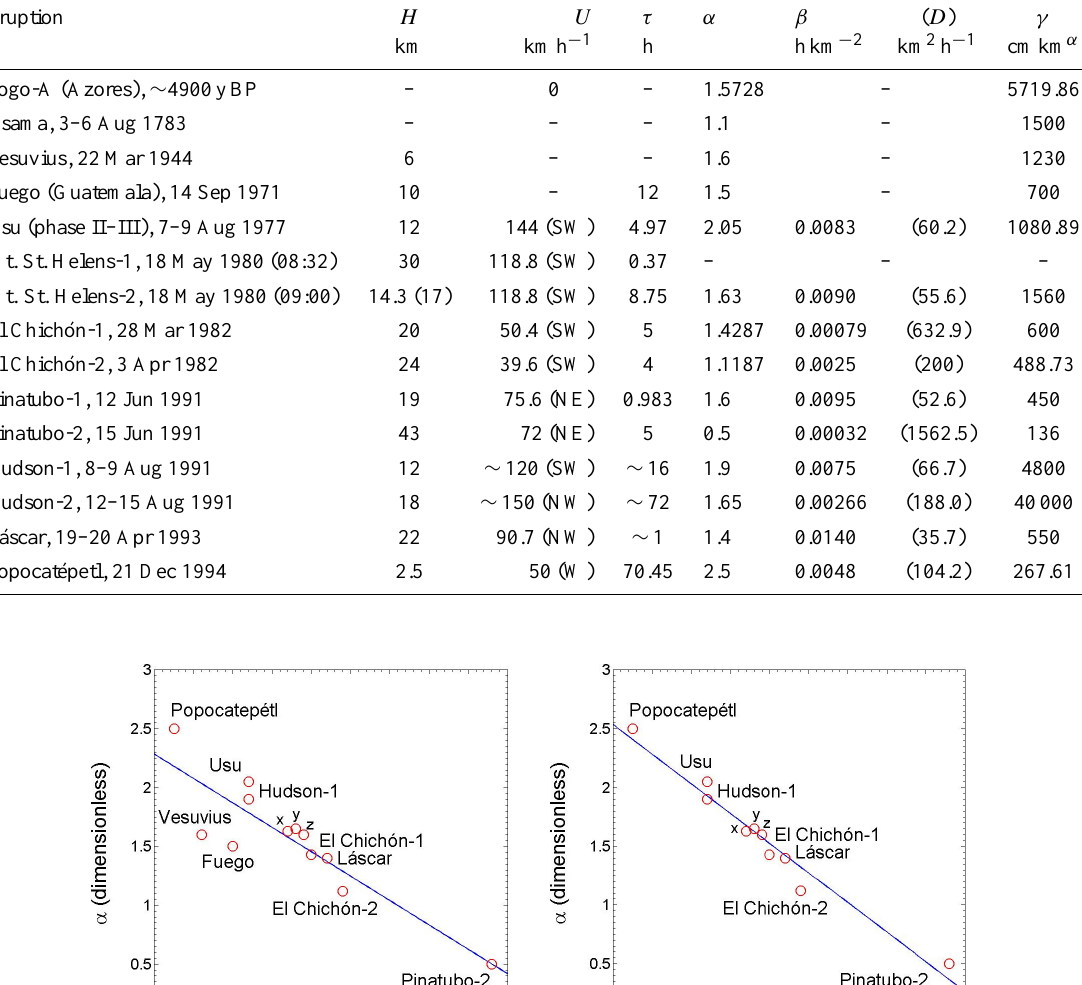
Table 3. Eruptive parameters. Column height H , wind velocity U , duration of the high-intensity phase of the eruption τ , and the semi- empiral model parameters α , β , and γ of the 14 well-documented eruptions.